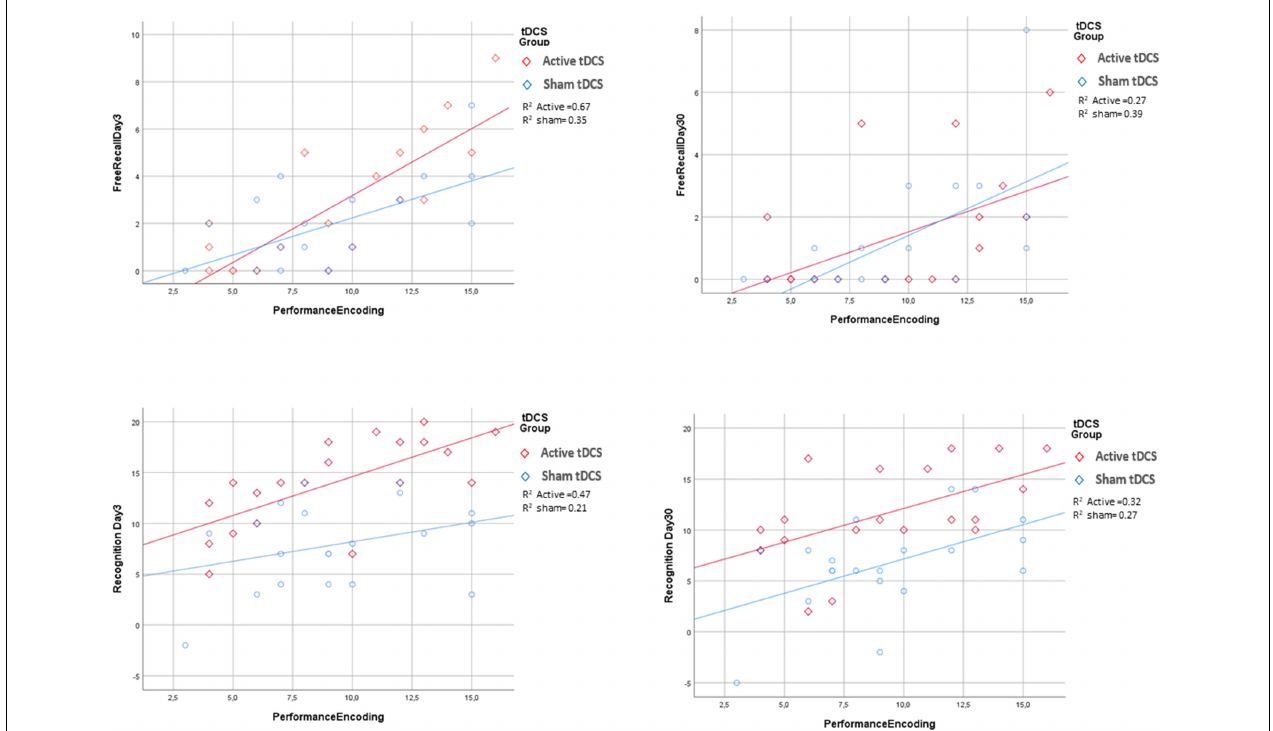
FIGURE 3 | Association between encoding performance and the four response variables by tDCS group. For all the response variables, increasing of performance encoding was associated with an increase of the response variable irrespectively for tDCS groups. R 2 is goodness of fit index of the two regression lines fitted for active and sham tDCS groups